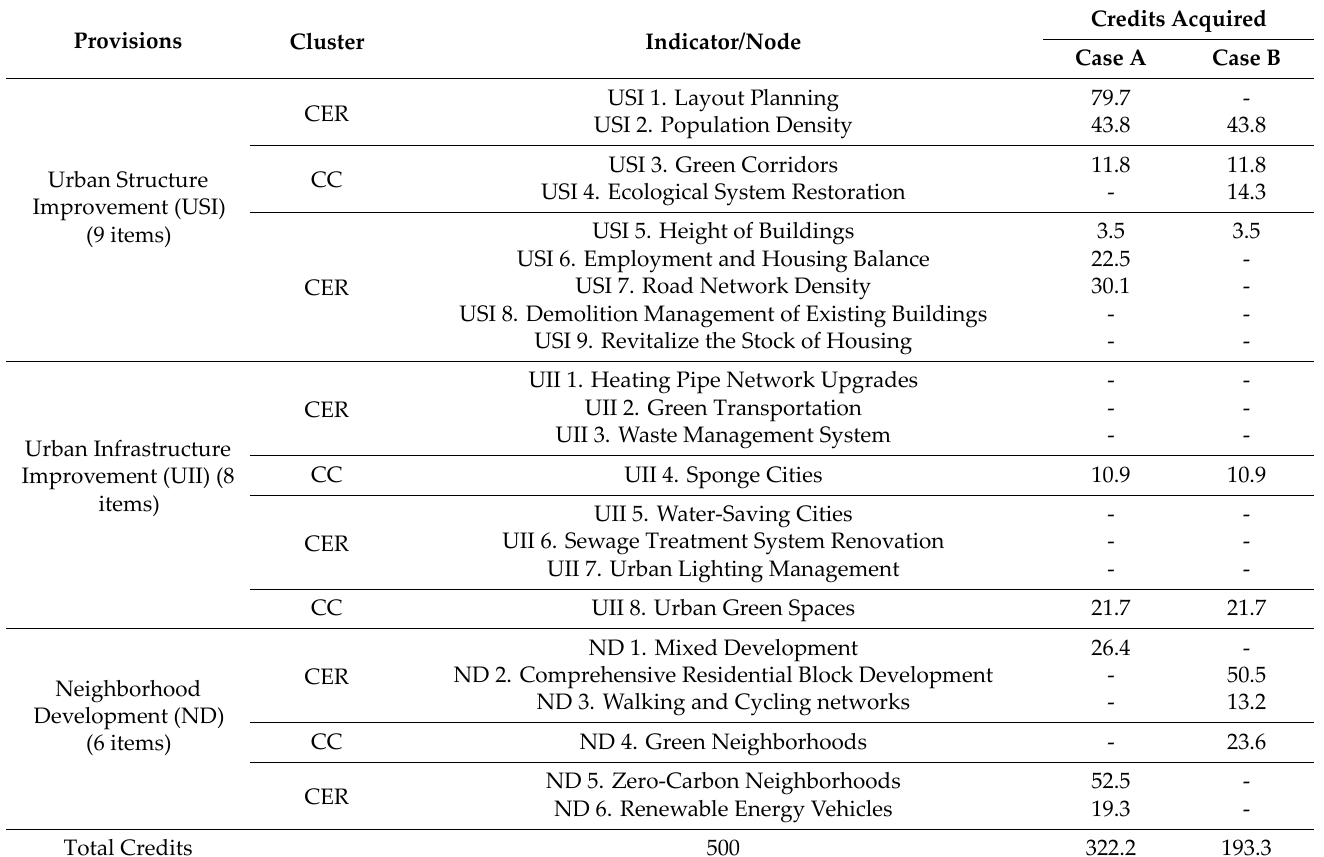
Table 11. Credits acquired for Case A and Case